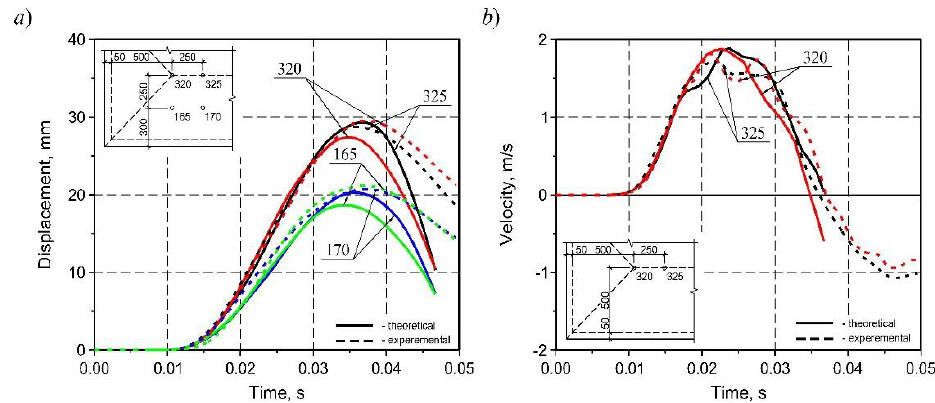
Fig. 3. Comparison of theoretical and experimental displacements ( а ) and velocities ( b ) of reinforced concrete slabs on rigid supports during their deformation in elasto-plastic phase.